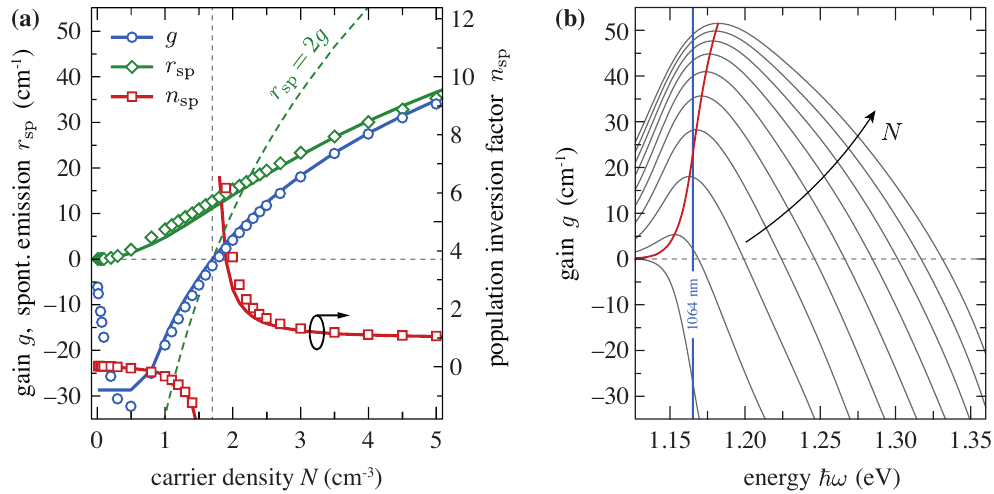
Figure 3. ( a ) Modal gain (blue) and rate of spontaneous emission (green), left axis, and population inversion factor (red), right axis, versus carrier density obtained from a microscopic simulation (symbols) and the analytic models (122), (123) and n sp = r sp / g (solid lines) for a fixed wavelength λ 0 = 1064nm. The dashed green line is the spontaneous emission computed using a constant population inversion factor n sp = 2. See the Appendix A for the consideration of the gain at a fixed wavelength within the framework of the present model. ( b ) Microscopically computed gain spectra for carrier densities ranging from N = 1 · 10 18 cm − 3 to 1 · 10 19 cm − 3 . The position of the fixed wavelength λ 0 is shown by a blue line, the peak gain position is indicated by a red